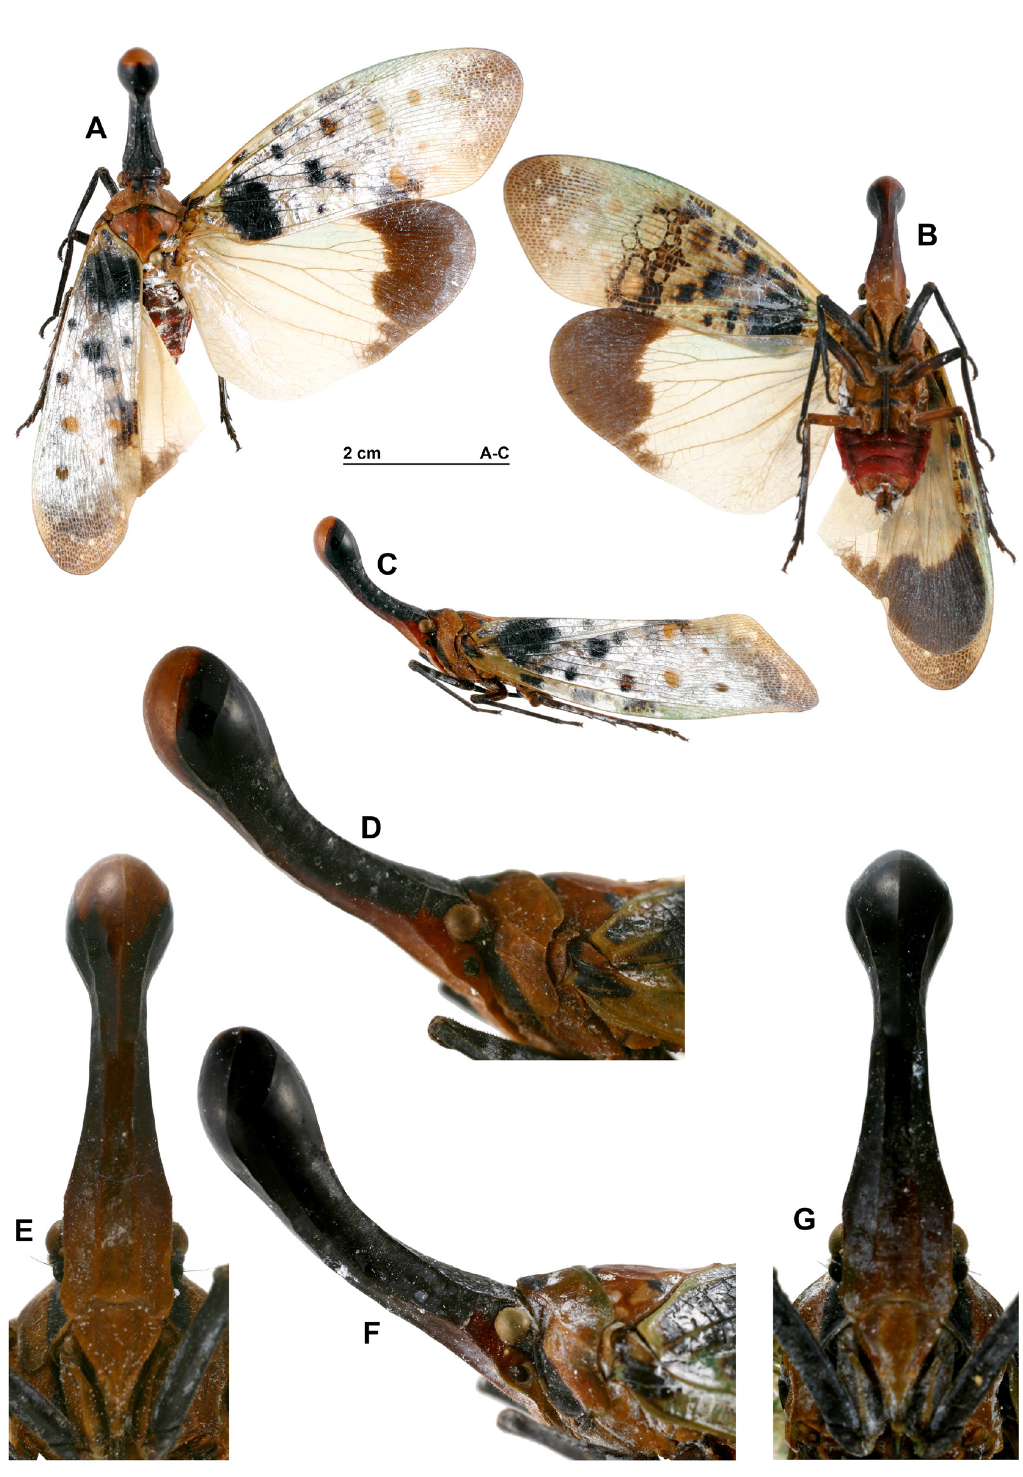
Fig. 10. Pyrops clavatus (Westwood, 1839), ♀♀, Thailand, Chiang Mai, Dec. 2007 (RBINS). A–E . Dark specimen with cephalic process brown ventrally. A . Habitus, dorsal view. B . Habitus, ventral view. C . Habitus, lateral view. D . Head and thorax, lateral view. E . Head, perpendicular view of frons. F–G . Dark specimen with black cephalic process. F . Head and thorax, lateral view. G . Head, perpendicular view of frons. D–G = not to